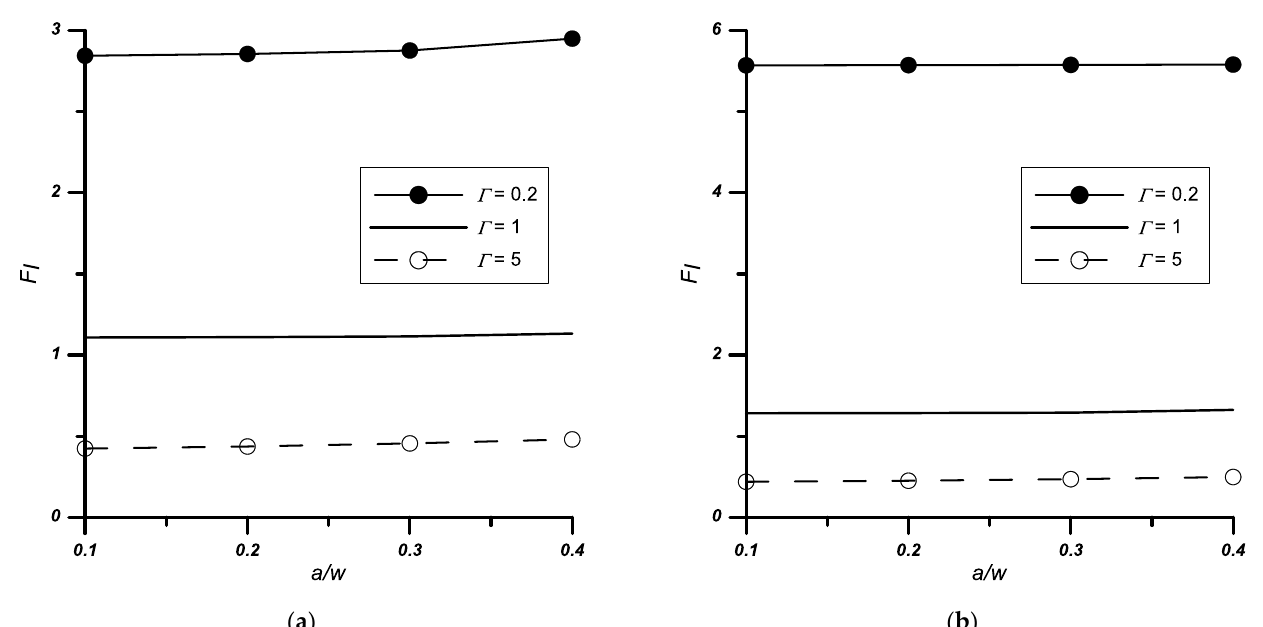
Figure 7. Variation of the normalised stress intensity factors F I with the relative stiffness Г and notch height a/w , ( a ) notched bi-material with 2 ψ = 0° apex angle, ( b ) notched bi-material with 2 ψ = 90° apex angle.